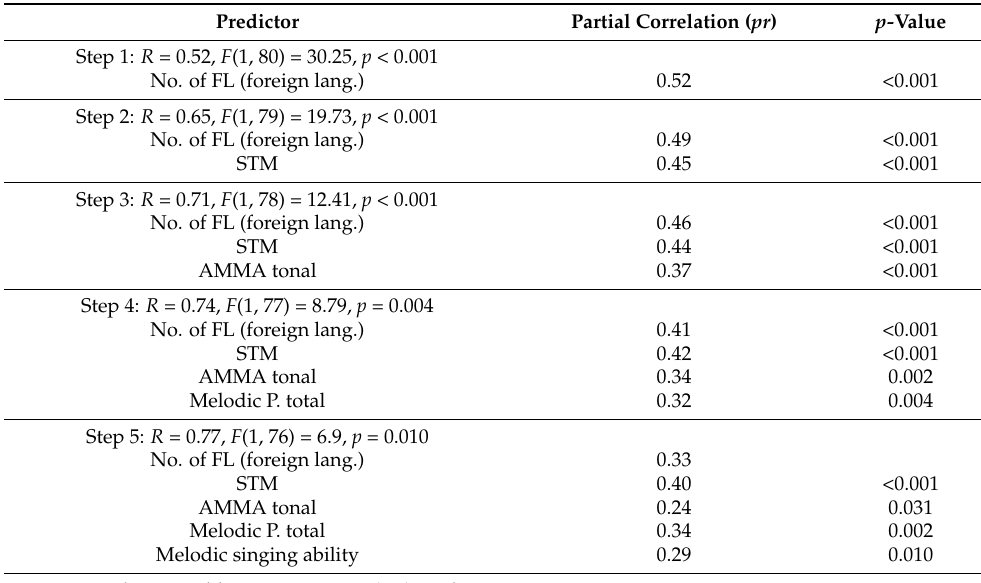
Table 4. Multiple regression models explaining the variance in pronunciation (PR) total.